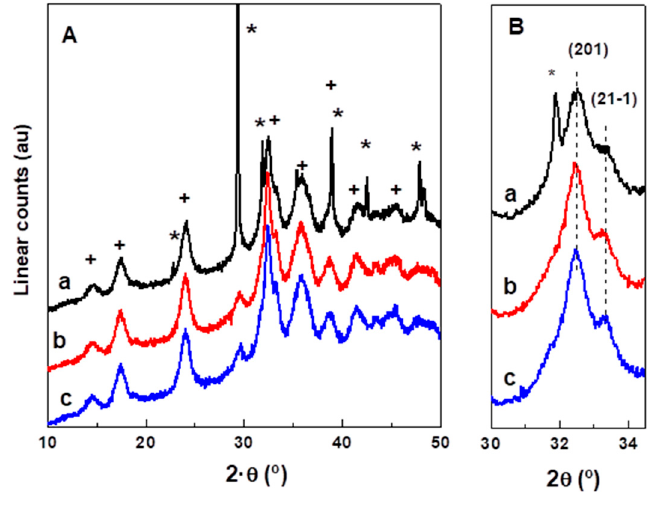
Figure 1. X-ray diffraction (XRD) patterns ( A ) and expansion in the interval 30-35° ( B ) of the hydroxycarbonate precursors: (a) W/O ( − ), (b) W1 ( − ), (c) W3 ( − ) ( + zinzian-malachite ((Cu/Zn) 2 CO 3 (OH) 2 , * NaNO 3